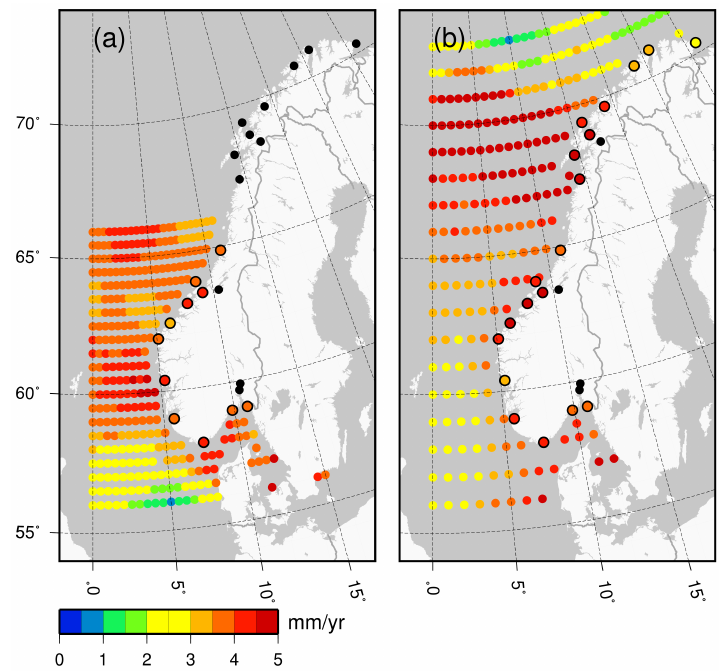
Figure 5. Sea surface height (SSH) changes measured using satellite altimetry over the period 1993 to 2016 from ( a ) the TOPEX/POSEIDON, Jason-1 and Jason-2 dataset and ( b ) the ERS-1, ERS-2, ENVISAT, and SARAL/AltiKa dataset. For the first dataset, observations are not available above 66 ◦ N owing to the orbital inclination of the satellites. Changes in SSH were computed for individual tide-gauge locations by averaging the altimetry observations within a spherical distance of 1 ◦ . The standard errors of the rates are typically 1 mm/year. Note that the data are corrected for geoid changes associated with